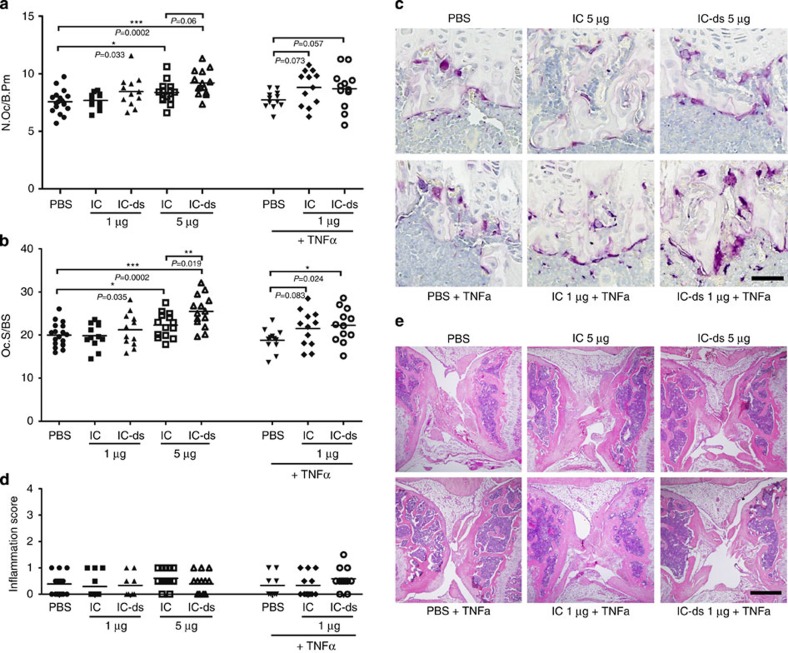
Non-sialylated immune complexes stimulate osteoclastogenesis in vivo.(a) Number of osteoclasts per bone perimeter (N.Oc/B.Pm) and (b) osteoclast surface per bone surface (Oc.S/BS) in tibial bone of C57BL/6 mice with intra-articular injection of the indicated amounts of native or desialylated (ds) murine immune complexes. Mice were injected at day 0 and day 4 with bone dissection at day 7. When indicated, 100 ng of TNFα was added to the first injection. Bars show mean±s.e.m. of ≥12 knee joints of three independent experiments. (c) Representative images of TRAP-stained tibial sections. Scale bar, 50 μm. (d) Inflammation score of haematoxylin-eosin stained joint sections with a score of 0 representing a healthy joint and a score of 4 representing a completely destroyed joint. Bars show mean±s.e.m. of ≥12 knee joints of three independent experiments. (e) Representative images of haematoxylin-eosin stained tibial sections. Scale bar, 500 μm. Statistical analysis was performed with Mann–Whitney U-test. *P<0.5, **P<0.01, ***P<0.001.